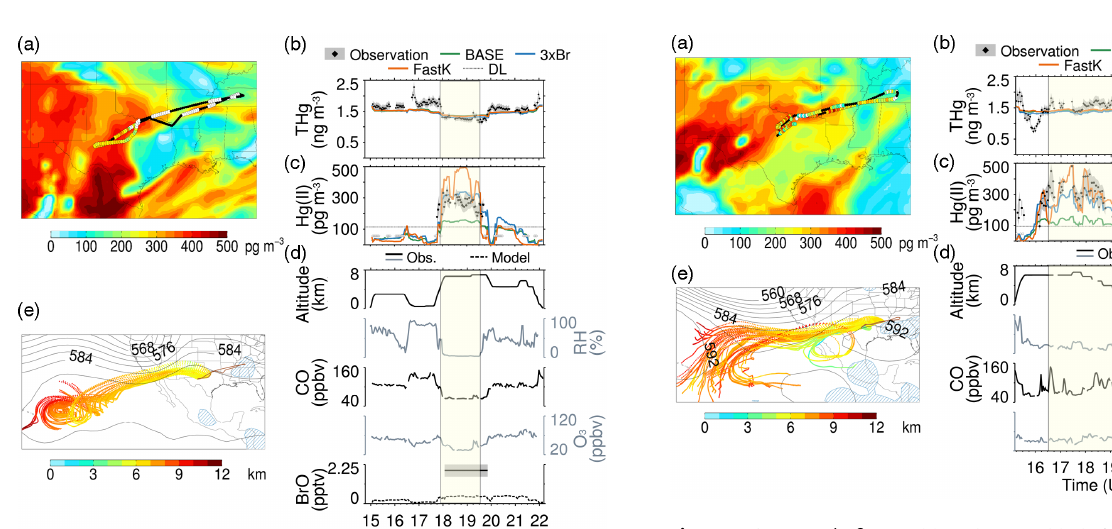
Figure 7. Case study for RF-09 on 24 June 2013. Same as Fig. 6, ex- cept that we do not show BrO concentrations which were not mea- sured on this